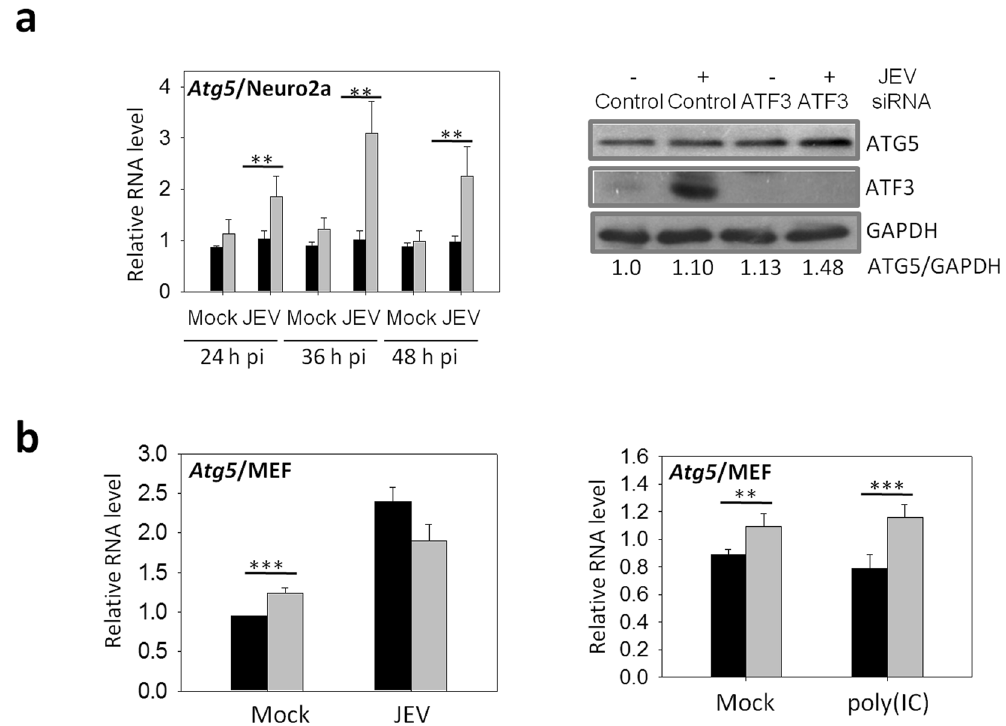
Figure 7. ATF3 negatively regulates Atg5 gene. ( a ) Neuro2a cells were treated with either a control non- targeting siRNA or the Atf3 -specific siRNA for 48 h and then infected with JEV (MOI 5). Relative expression of Atg5 at different times pi was studied by qRT PCR, and the mean is plotted (left panel). Cell lysates were prepared 24 h pi, and Western blotted for ATG5 and ATF3. Shown below is the ratio of ATG5/GAPDH. ( b ) MEF cells were treated with either a control non-targeting siRNA or the Atf3 -specific siRNA for 48 h and then infected with JEV (MOI 5) (left panel) or transfected with 1 μ g/ml poly(IC) (right panel). Relative expression of Atg5 , 24 h post-treatment, was studied by qRT PCR, and the mean is plotted. Transcript level in control siRNA- treated cells is shown by the black bar while that in the Atf3 siRNA-treated cells is shown by the gray bar. The Gapdh levels were used for normalization. The experiments were done in triplicates on three different occasions. The statistical significance of the difference between the data was established by Student’s t-test; * p < 0.05; ** p < 0.01; *** p <